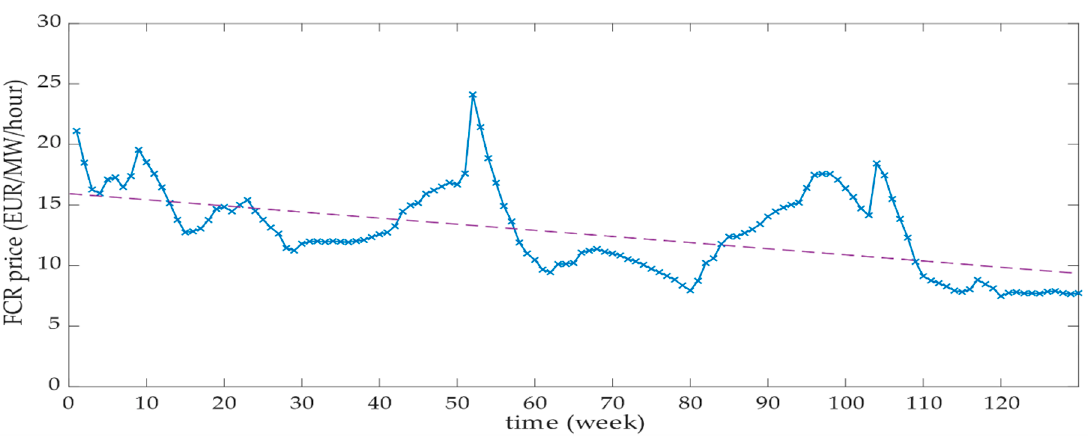
Figure 21. Power reserve payment on the FCR cooperation interconnected market.